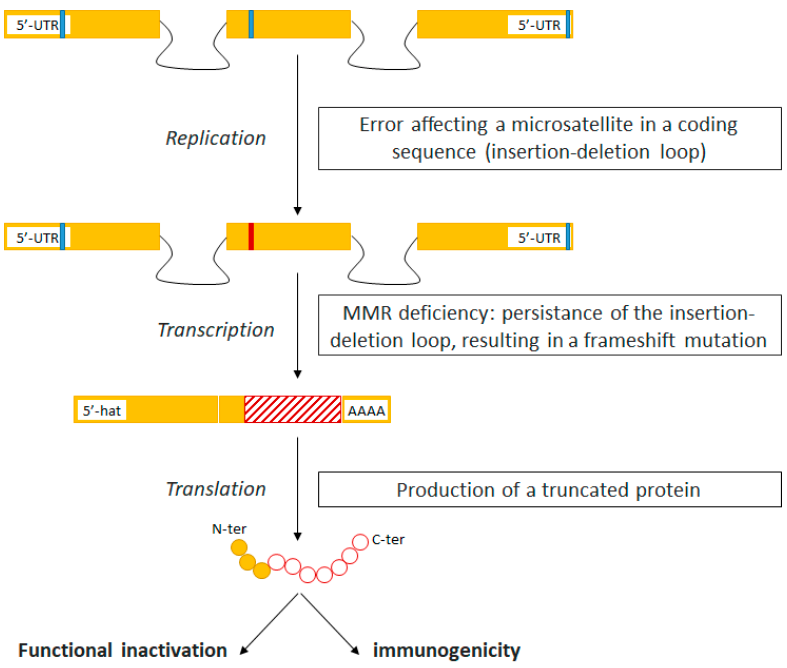
Figure 1. The immunogenicity of tumors with mismatch repair deficiency. Yellow bars: exons; Black lines: introns; Blue dash: non-mutated microsatellite; Red dash: mutated microsatellite. lines: introns; Blue dash: non-mutated microsatellite; Red dash: mutated